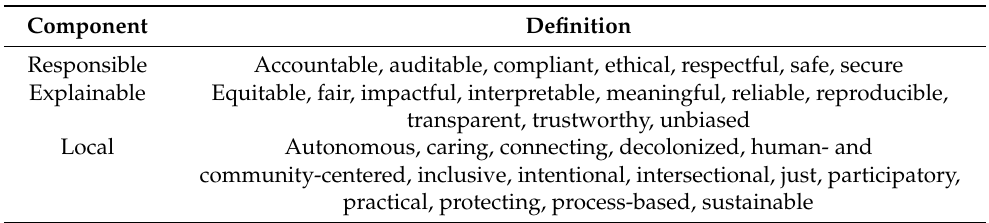
Table 3. The three components of the “Responsible, Explainable, and Local Artificial Intelligence for Clinical Public and Global Health in the Global South” (REL-AI4GS)